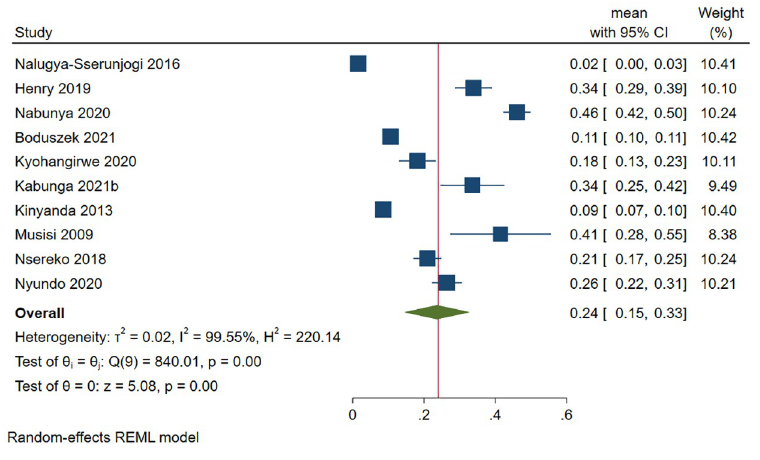
Fig 12. Forest plot on the prevalence of depression among children and adolescents in Uganda.